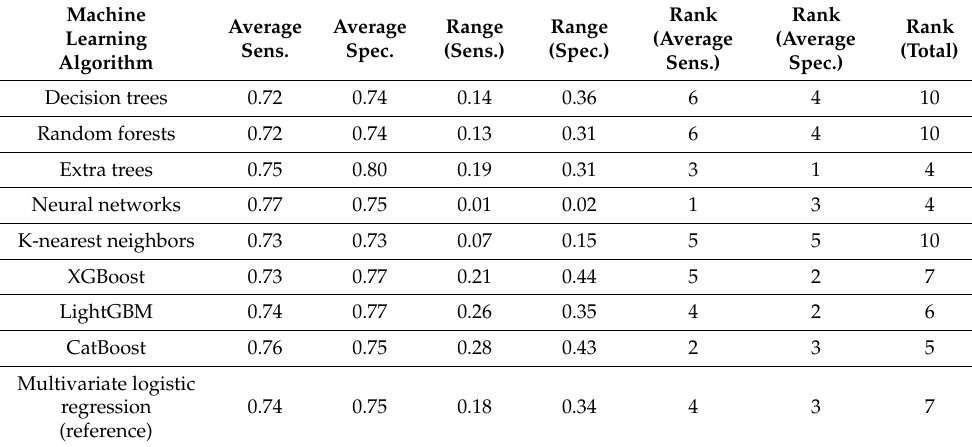
Table 4. Ranking of the ML algorithms according to their sensitivity and specificity. The least rank means the highest sensitivity (sens.) or specificity